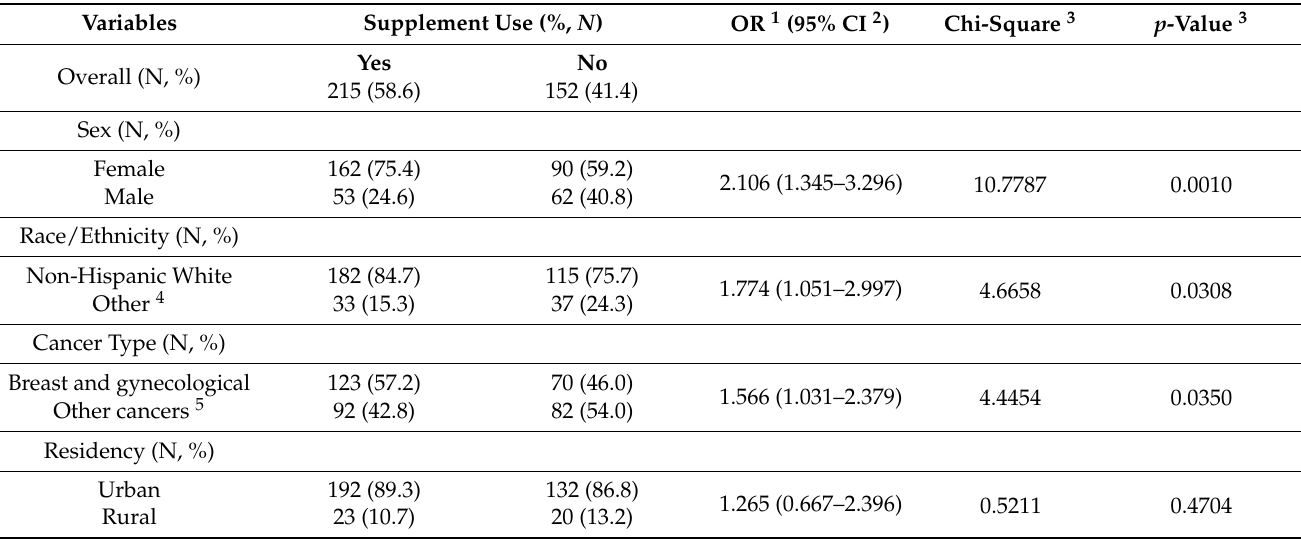
Table 2. Chi-square test of association between supplement use and medical/socio-demographic variables versus non-use among 367 older cancer